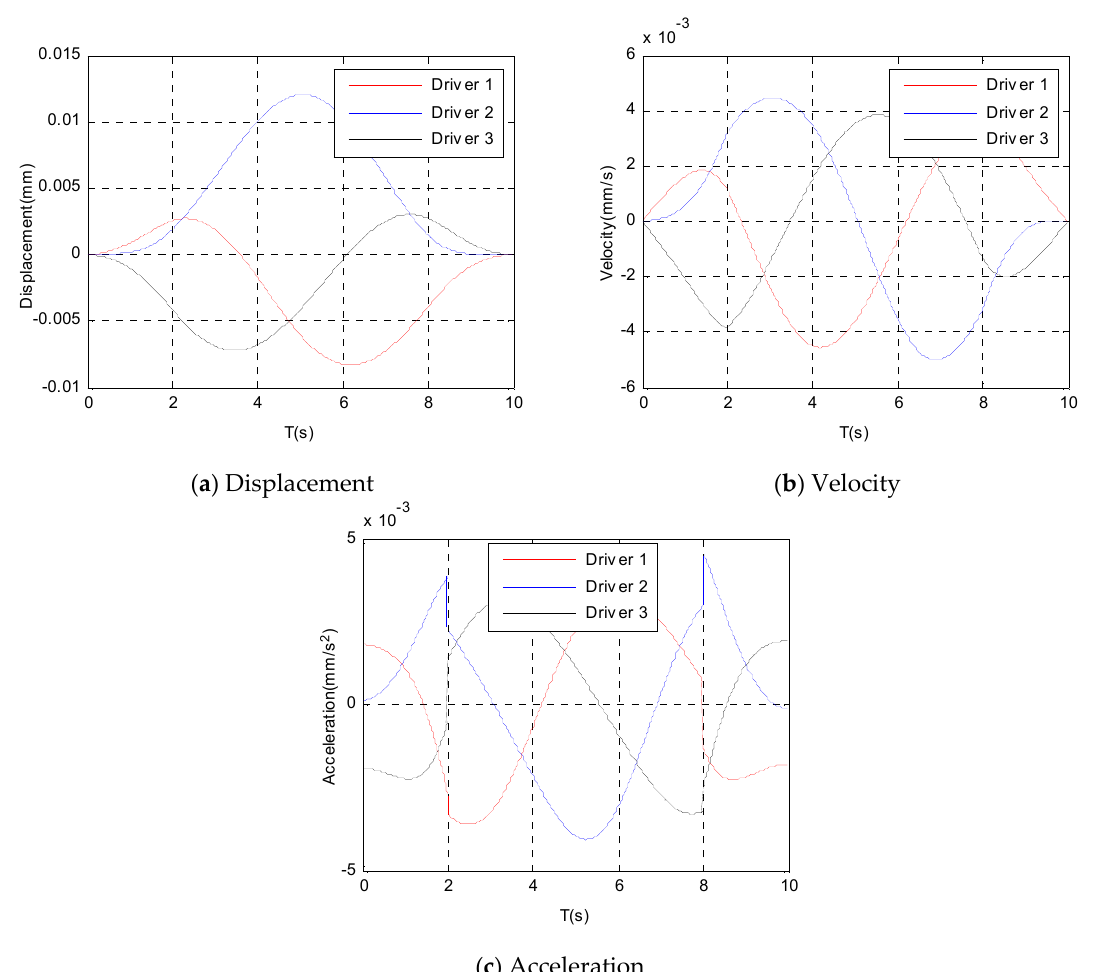
Figure 4. Displacement, velocity, and acceleration of the three motors.